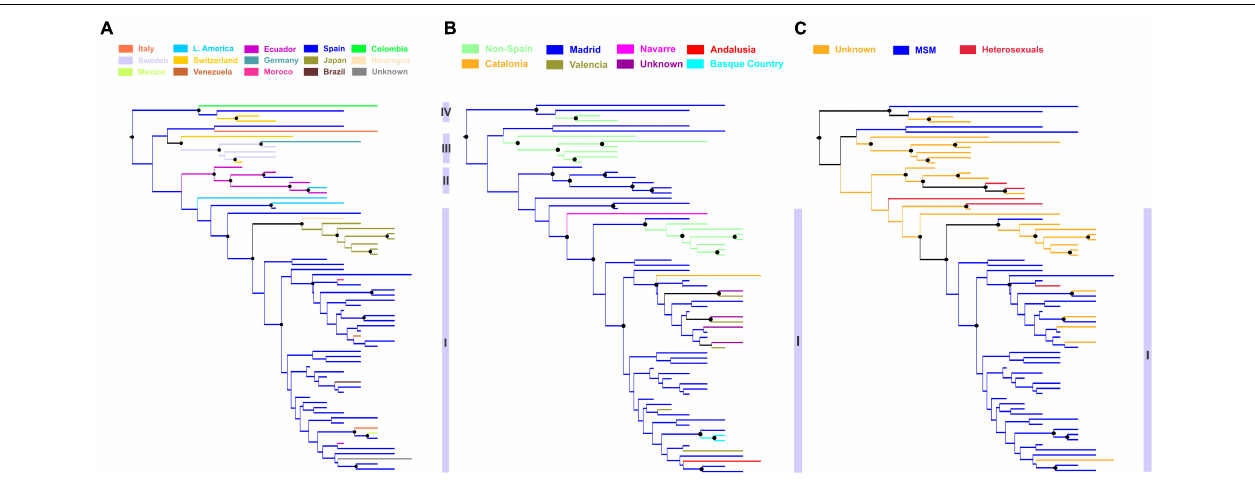
FIGURE 4 | Phylogeographic topology estimated by Mesquite v3.4 for largest HIV-1 CRF02_AG subepidemic in Spain, showing the viral clades in different colors according to the: (A) ethnic origin of the HIV-1 diagnosed patient, (B) Spanish autonomous community of sampling, and (C) transmission risk group of the HIV-1 diagnosed patient. Branch lengths were longer within subclusters III, IV than within subclusters I and II, suggesting higher genetic diversity. Black disks indicate nodes with posterior probability greater than 0.85.